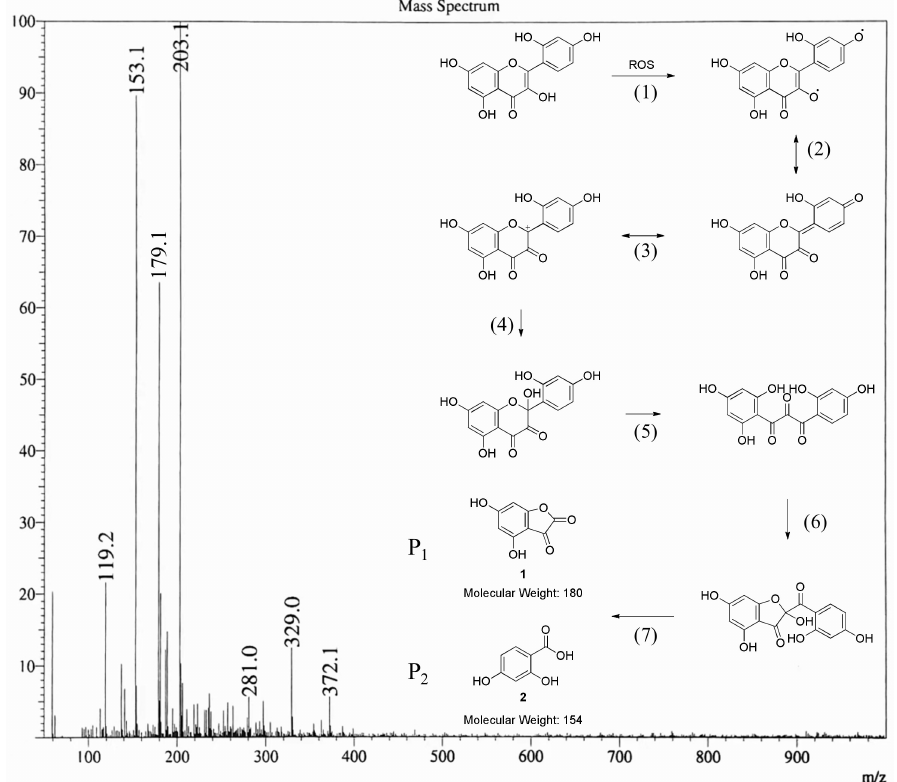
Figure 6. MS of degradation product (negative ion mode) and speculated degradation pathway of the morin.